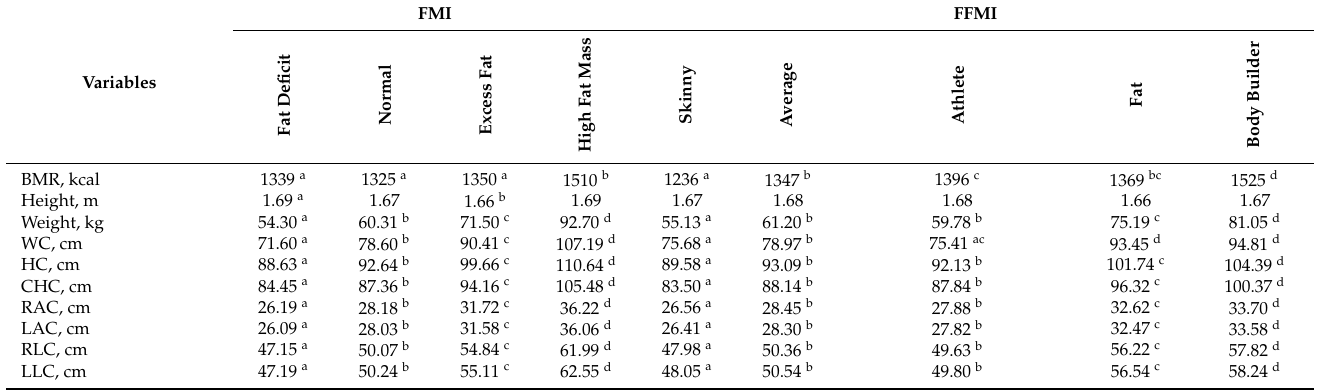
Table 3. Relationship between FMI, FFMI, FM/FFM, FMI and FFMI and Body Mass Index with anthropometric parameters and premature mortality